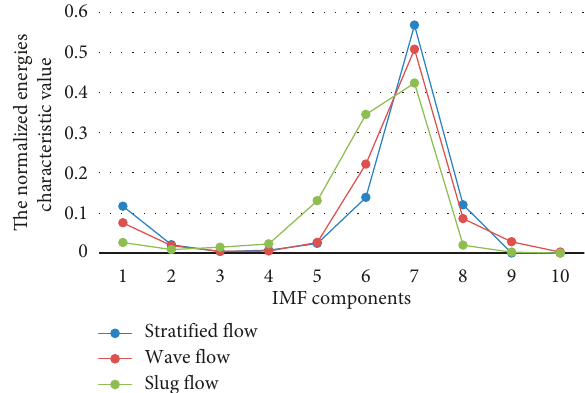
Figure 16: The normalized energies characteristic values of each IMF energy component in the three-flow